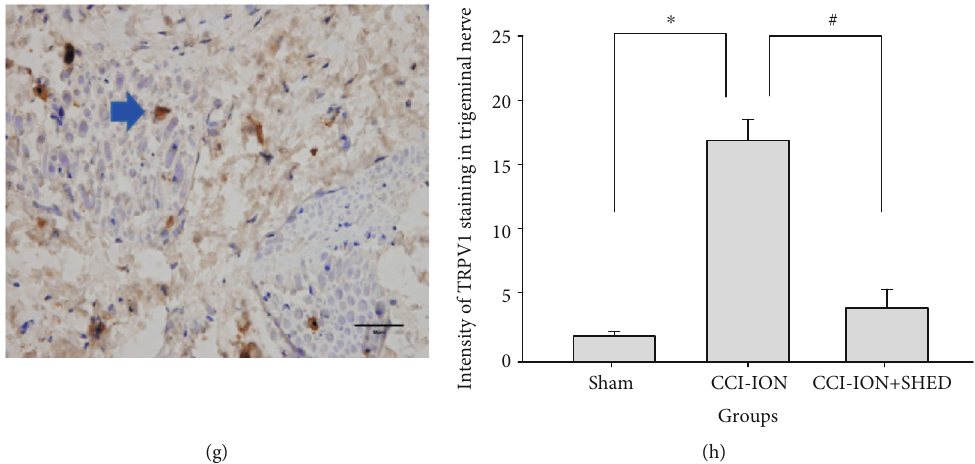
Figure 7: Local SHED transplantation suppresses upregulation of TRPV1-positive cells in CCI-ION rats. TRPV1-positive cells in the TG (a) and trigeminal nerve (e) of sham rats. TRPV1-positive cells in the TG (b) and trigeminal nerve (f) of CCI-ION rats without SHED injection. TRPV1-positive cells in the TG (c) and trigeminal nerve (g) of CCI-ION rats with local SHED administration ( 1 × 10 5 cells, 0.2mL). (d) Quanti fi cation of TRPV1-positive cells in the TG. (h) Quanti fi cation of TRPV1 staining in the trigeminal nerve. Scale bar = 50 μ m . ∗ p < 0 : 05 vs. sham, # p < 0 : 05 vs. CCI-ION rats without SHED transplantation. All data are expressed as the mean ± SEM ( n = 6 rats in each group).